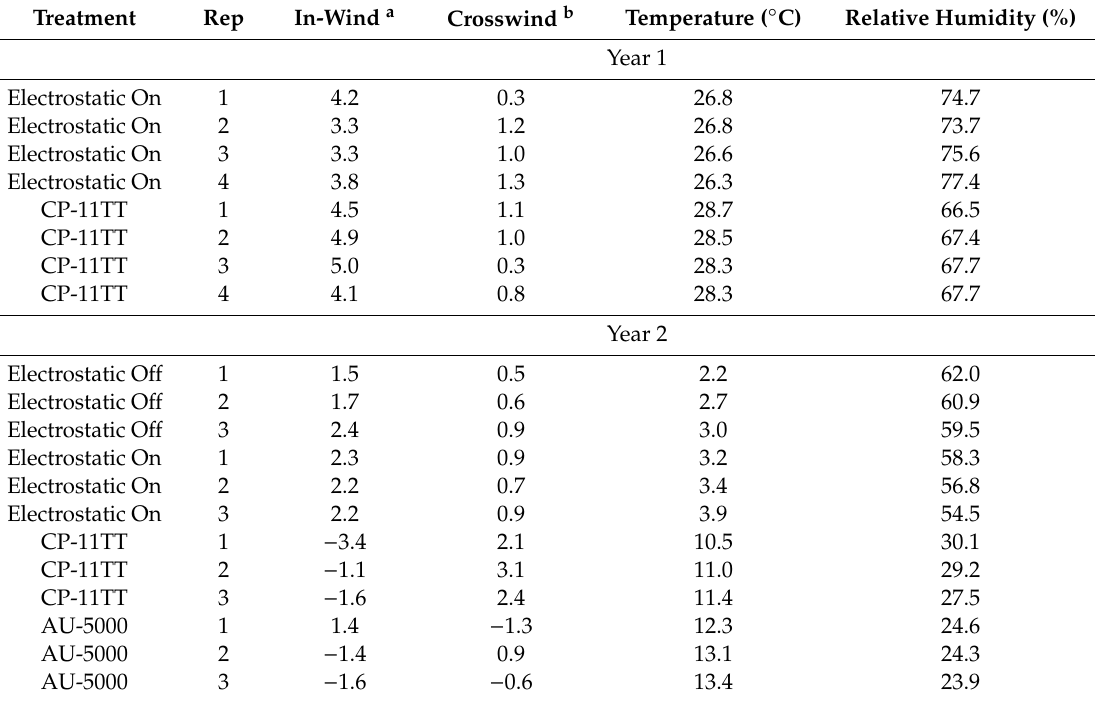
Table 3. Weather conditions by treatments and replications during the study in year 1 and year 2. Treatment Rep In-Wind a Crosswind b Temperature ( ◦ C) Relative Humidity (%)